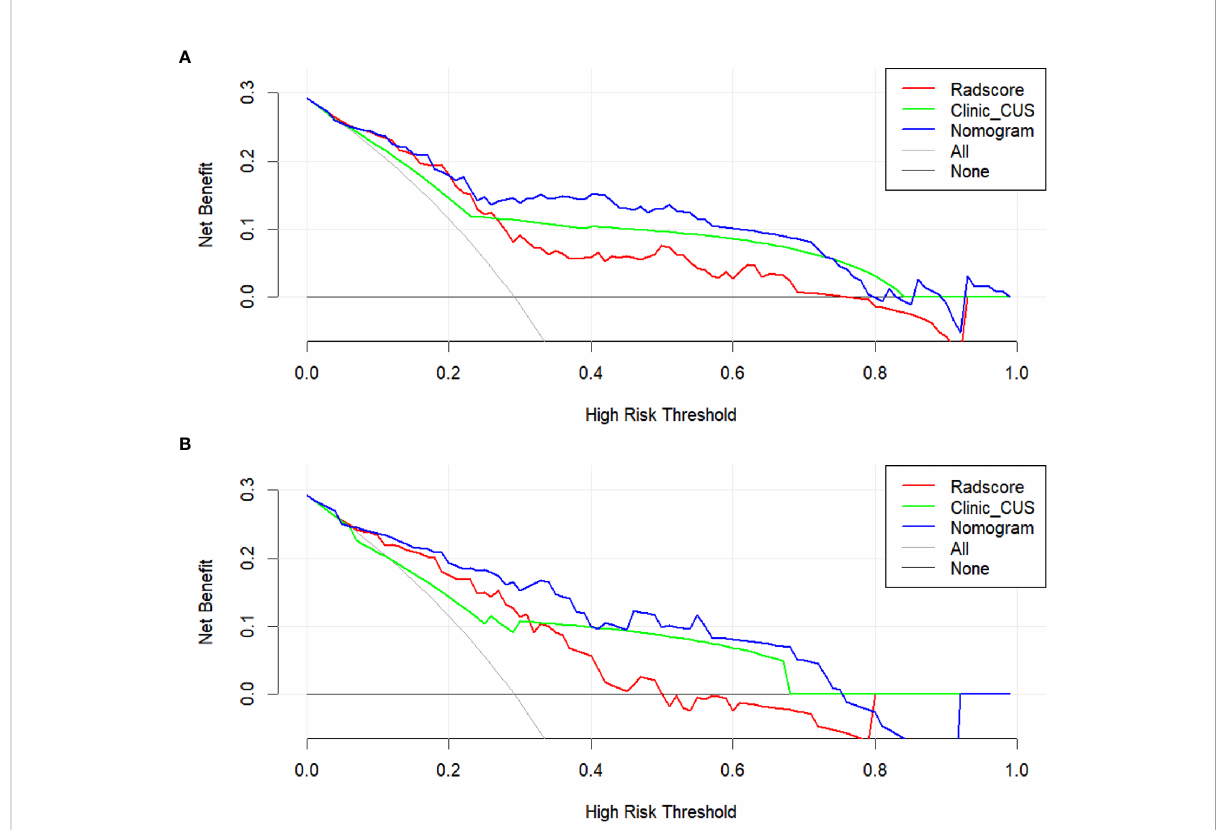
FIGURE 7 DCA for the clinical value assessment of the three models in the training dataset (A) and validation dataset (B) , respectively. The X-axis indicates the threshold probability, and the Y-axis represents the net bene fi t. The gray line indicates the assumption that all patients are LVI-positive cases; the black line represents the assumption that all patients are LVI-negative cases. The red, green, and blue lines refer to the Radscore, clinic_CUS, and radiomics nomogram models,